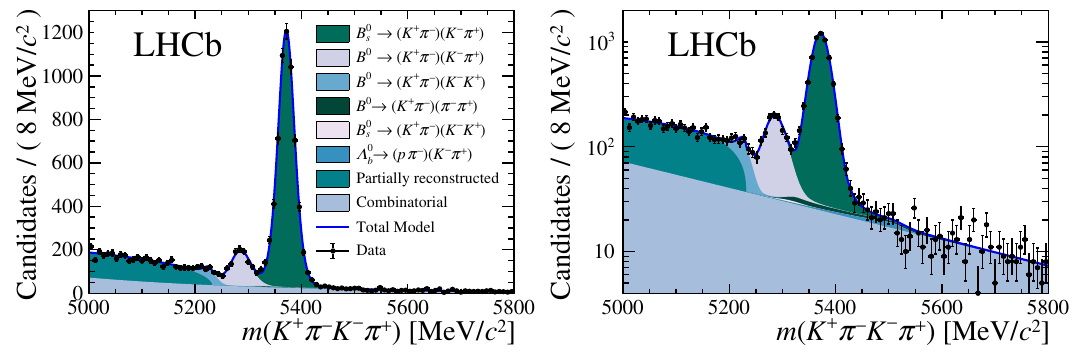
Figure 3 . Four-body invariant mass distribution on a (left) linear and (right) logarithmic scale superimposed with the mass (cid:12)t